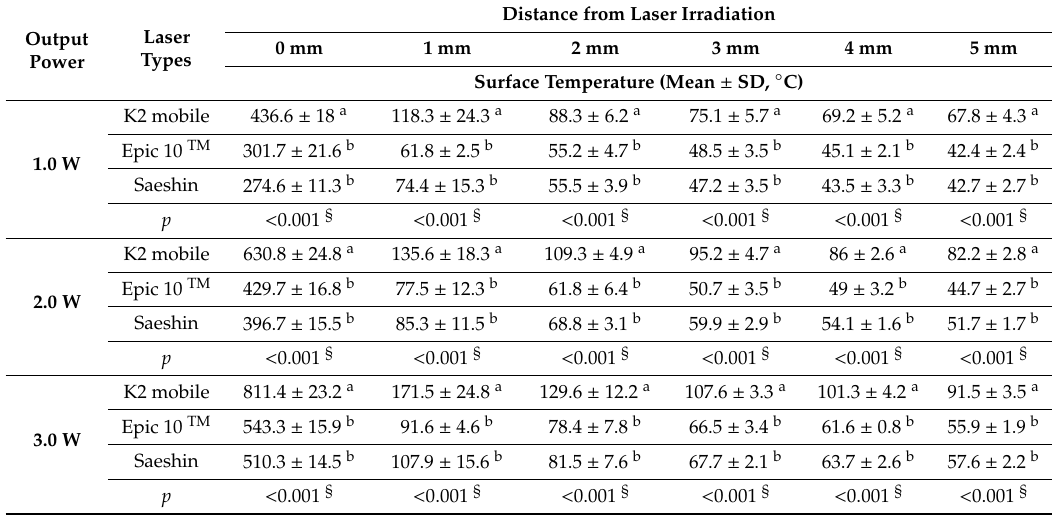
Table 2. Comparison of temperature after laser irradiation using three types of dental diode lasers. Output Power